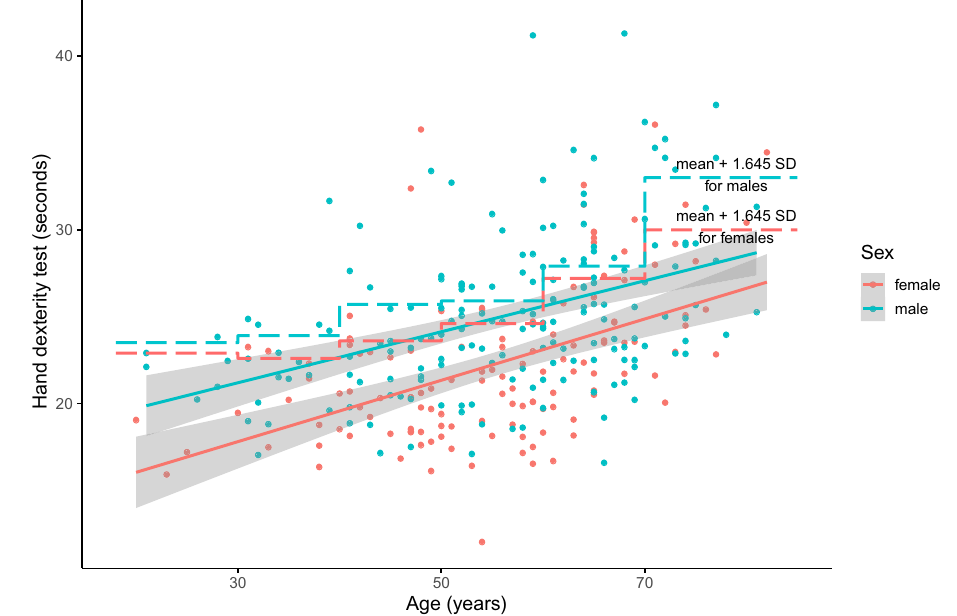
Figure 2. Scatterplot of age and the time to succeed the hand dexterity test, presented per sex. The solid lines represent the association between age and hand dexterity per sex, and the shaded area represents its 95% confidence interval. The dashed lines represent the age- and sex-specific mean + 1.645 times the age- and sex-specific standard deviation of a reference population, stratified by sex 12 . As such, they represent the 95th percentile of an age and sex-specific reference population. Participants above the dashed lines were defined as having an impaired hand dexterity.